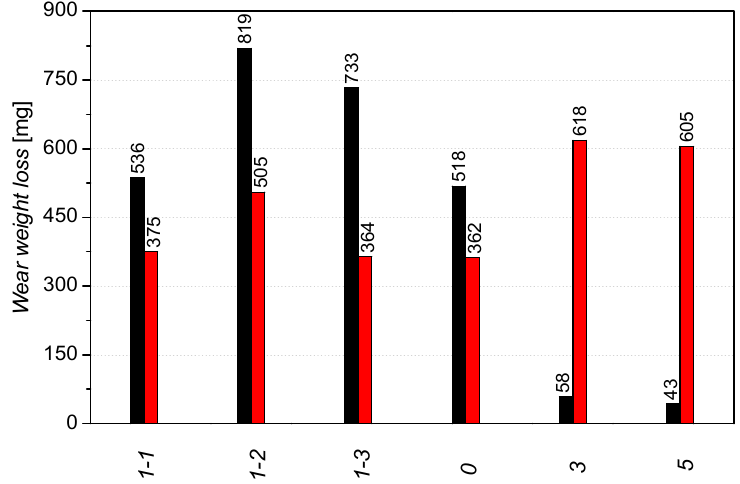
Figure 9. Results of the Amsler test of the sample (black) and counter-sample (20H2N4A, red) after 8h.